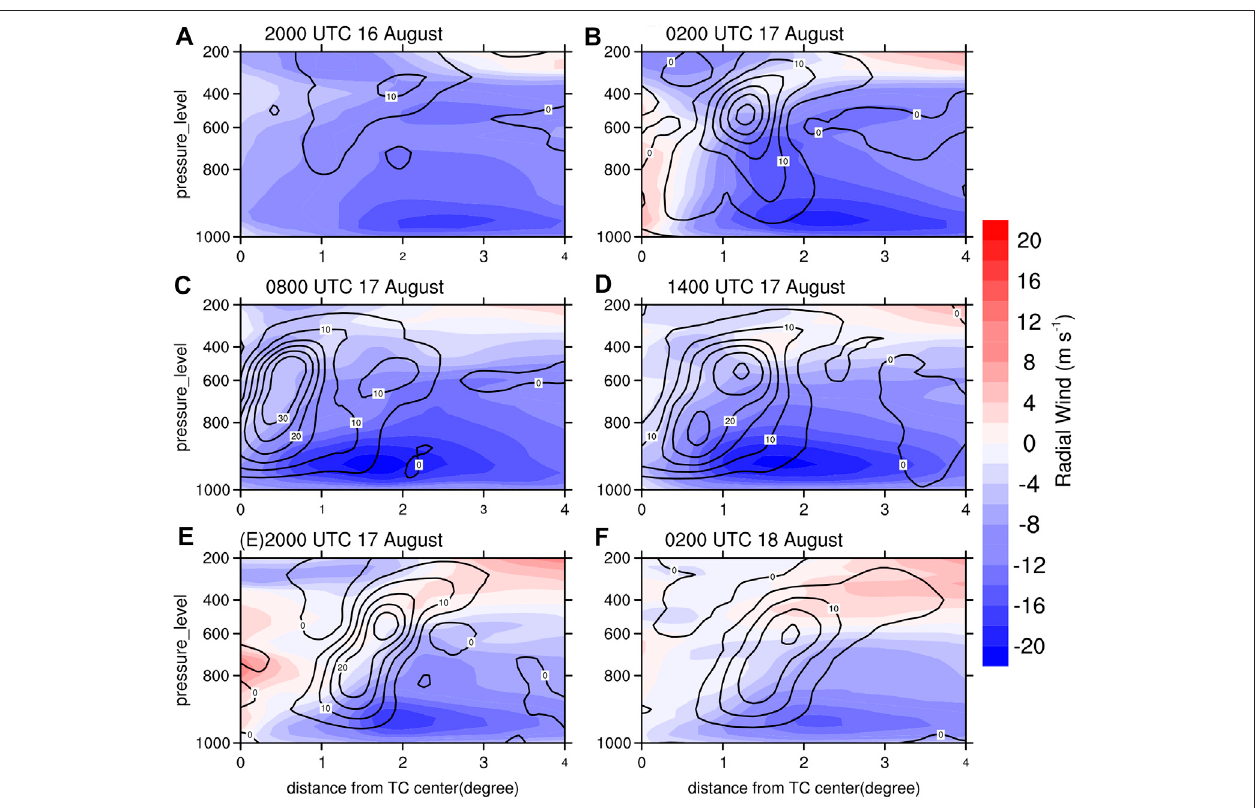
FIGURE13| Northeastquadrant meanradialwind(shading,ms − 1 )andvertical motion(contours,ms − 1 ): (A) 2000UTC16August, (B) 0200, (C) 0800, (D) 1,400, (E) 2000 UTC 17 August, (F) 0200 UTC August 18,